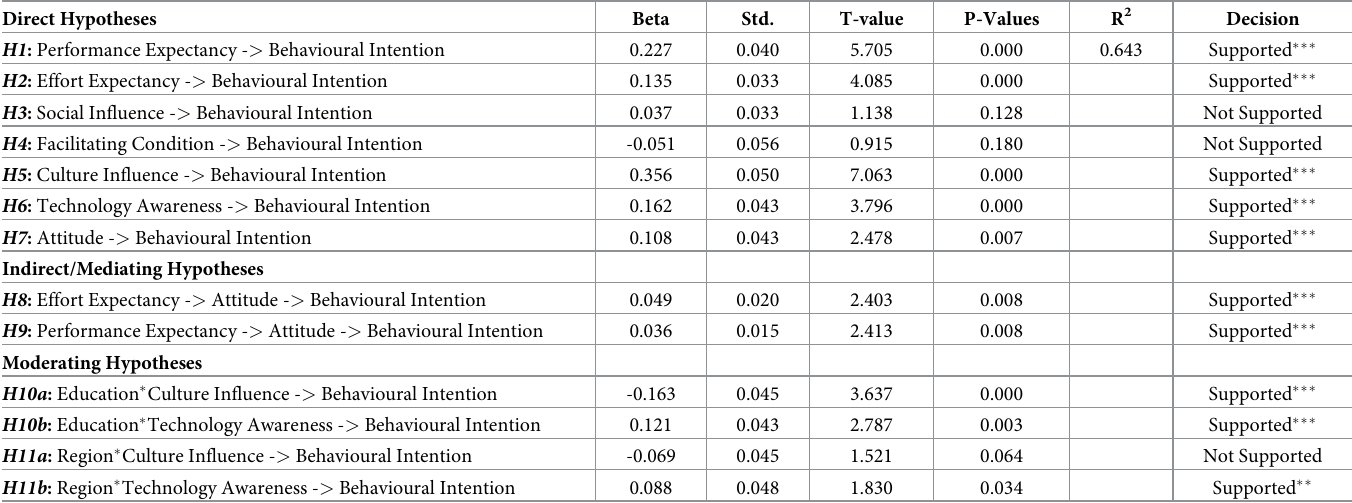
Table 6. The results of the structural model.